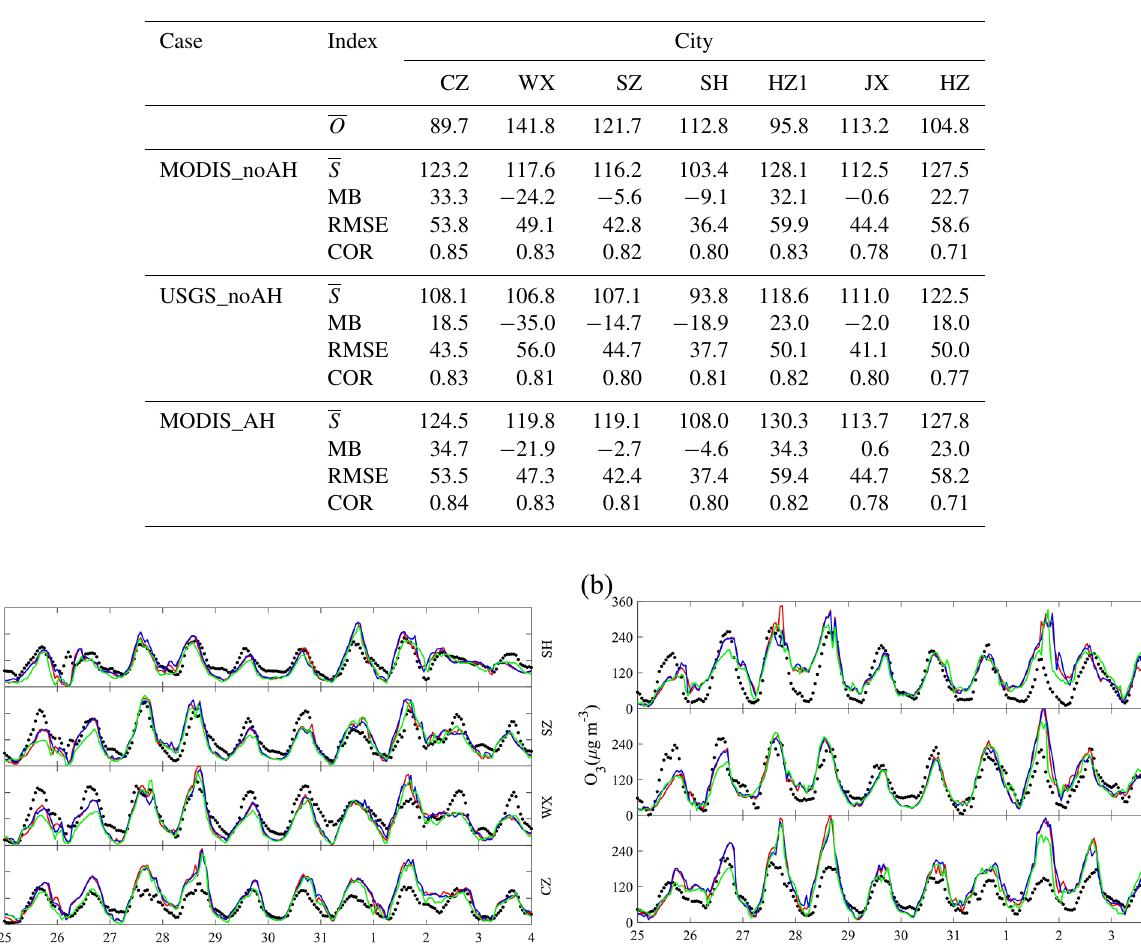
Table 5. Statistical metrics in O 3 (µgm − 3 ) between observations and simulations.